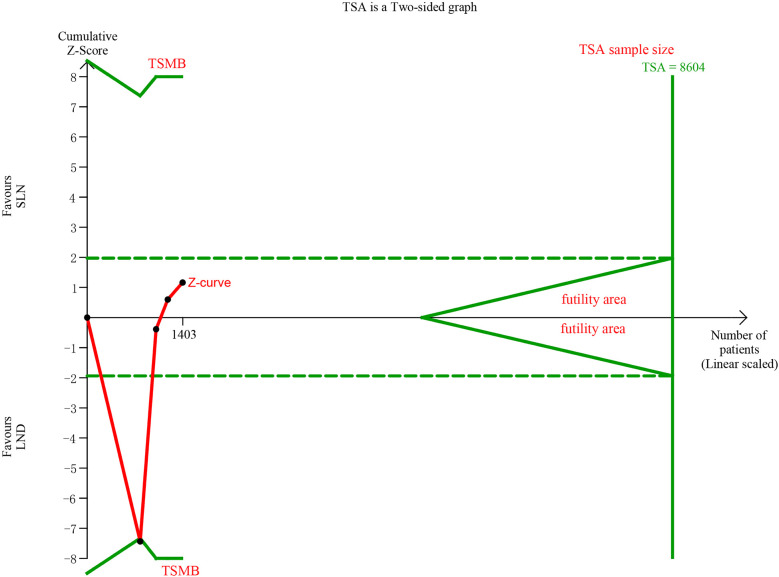
TSA of para-aortic lymph nodes removed, α = 0.05, β = 0.8, two-sided test.